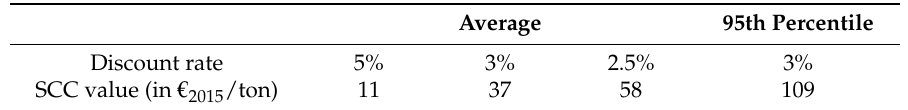
Table 5. Social cost of carbon estimates of CO 2 emissions from the Interagency Working Group on Social Cost of